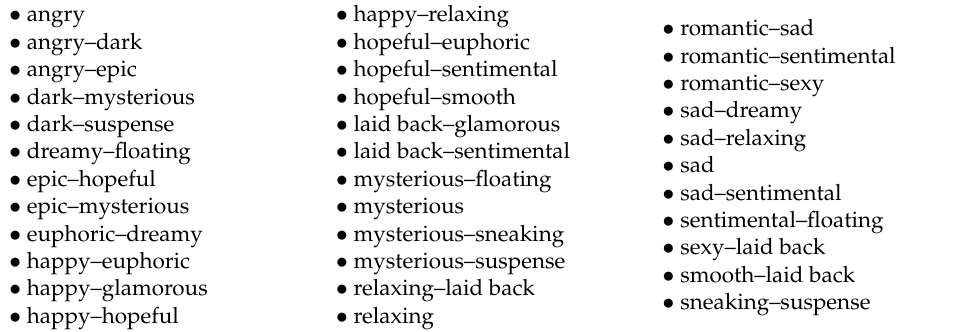
Table 2. Mood/emotion